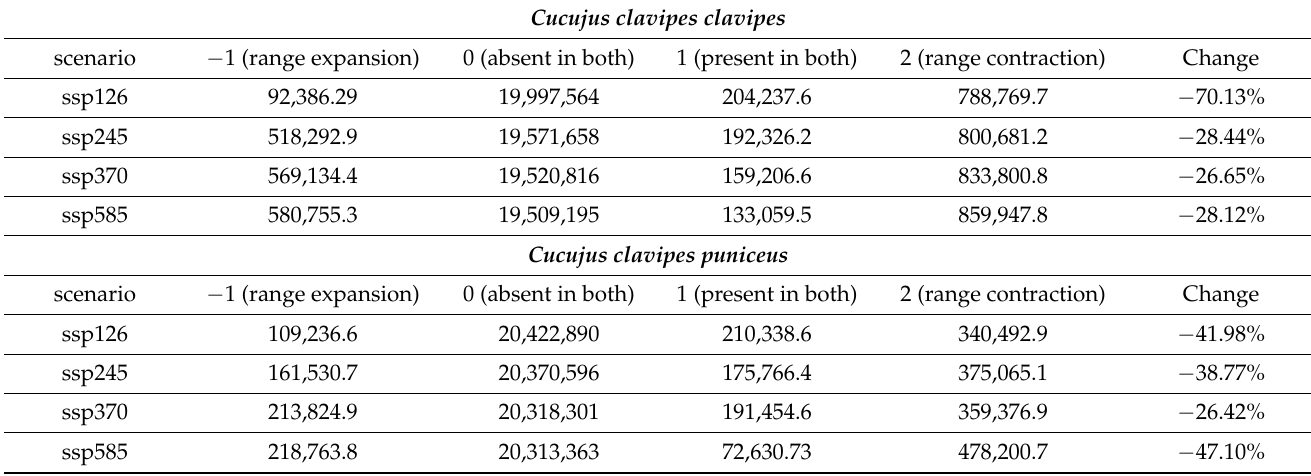
Table 3. Future changes in coverage of suitable niches of studied taxa [km 2 ]. Cucujus clavipes